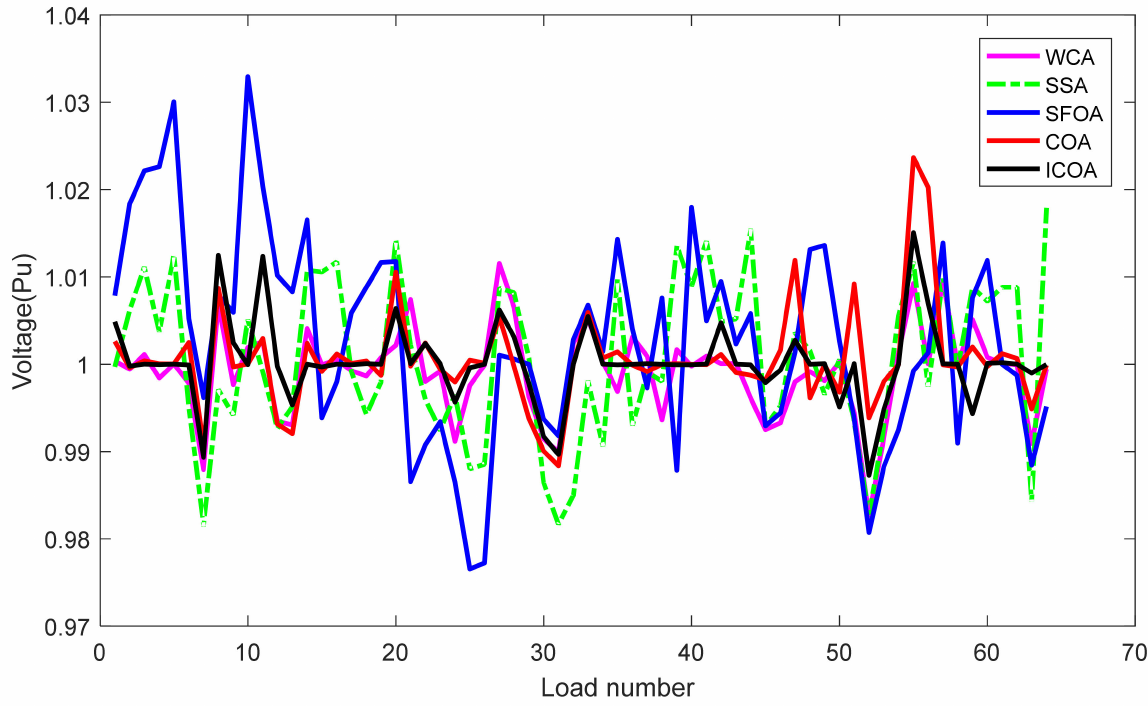
Figure 12. The voltage of all loads obtained by five implemented